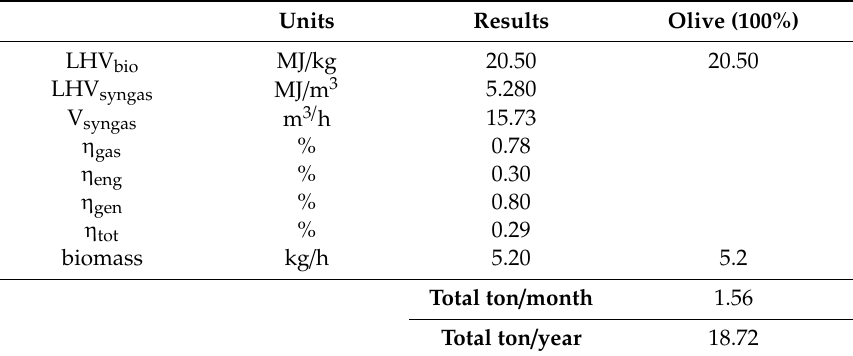
Table 10. Gasification results and yields for 100% olive biomass (Source: